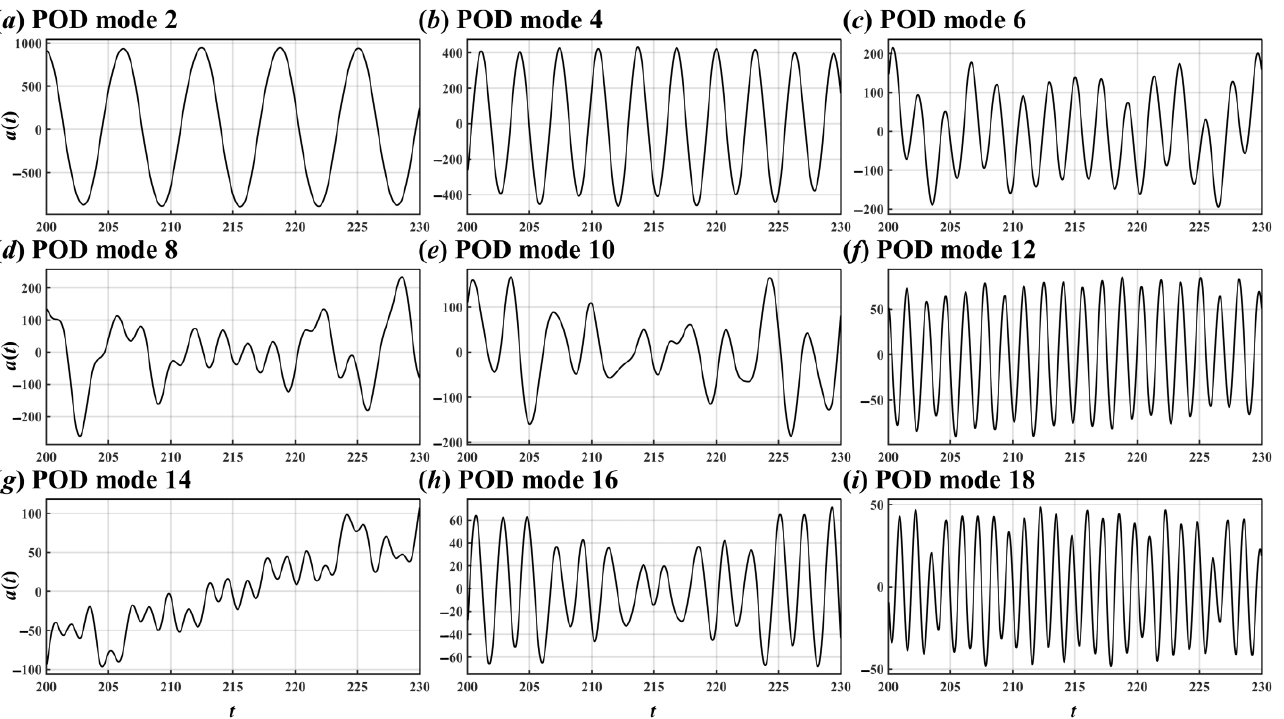
Figure 28. Contours of the 2nd ( a ), 4th ( b ), 6th ( c ), 8th ( d ), 10th ( e ), 12th ( f ), 14th ( g ), 16th ( h ), and 18th ( i ) POD modes on the xy plane for the flow around the two crossing cylinders in 90° arrange- ment.